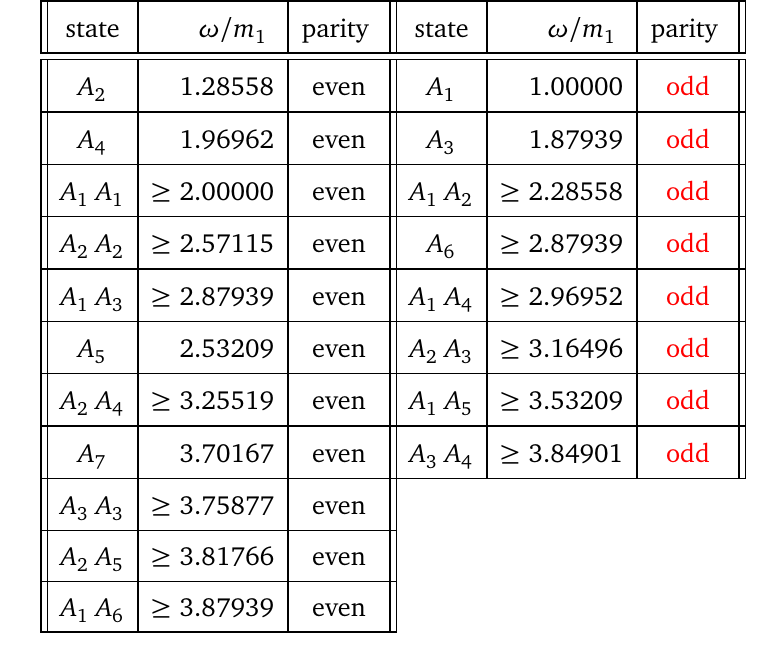
Table 5.1: Lowest energy states sorted according to the energy of their threshold and their (cid:90) 2